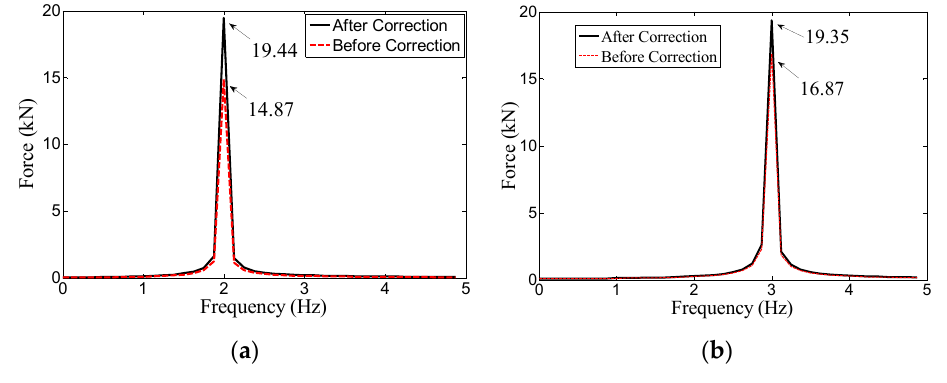
Figure 22. ( a ) The frequency-domain results of H1-1 before and after correction; ( b ) The frequency-domain results of H1-2 before and after correction.